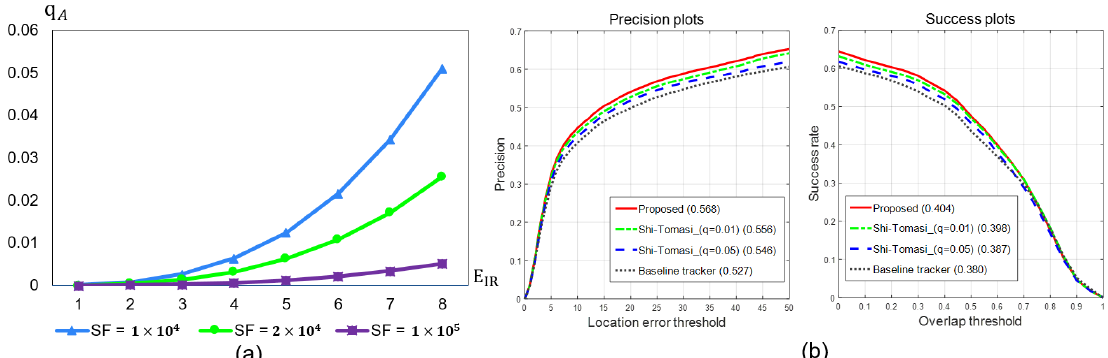
Figure 6. An experimental result for the optimal scale factor value ( SF ) value and the comparison of feature point detectors. ( a ) A comparison of minimum accepted quality values following SF and ( b ) different tracking performances by different feature point detecting approaches.